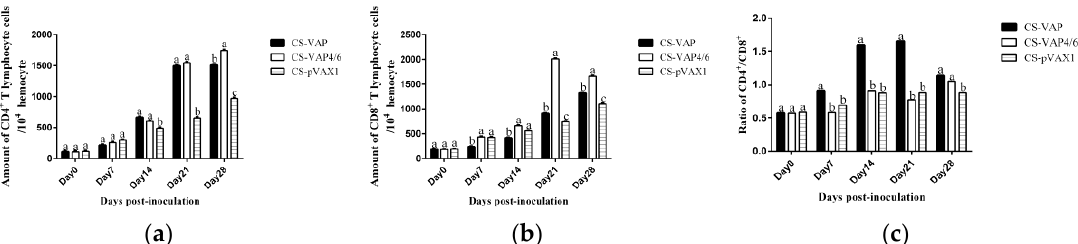
Figure 6. Changes of CD4 + ( a ) and CD8 + ( b ) T cells in the blood of experimental mice. ( c ) shows the ratio of CD4 + and CD8 + T cells. The amounts of CD4 + and CD8 + T cells significantly increased in the blood of treated groups at 21 and 28 days post-inoculation compared with the control group ( p < 0.05). Moreover, the amounts of CD4 + and CD8 + T cells of CS-VAP4 / 6 rose significantly compared with CS-VAP at 28 days ( p < 0.05). There was a significant increase in the ratio of CD4 + to CD8 + T cells of CS-VAP compared with CS-VAP4 / 6 and CS-pVAX1 from 7 to 21 days ( p < 0.05).